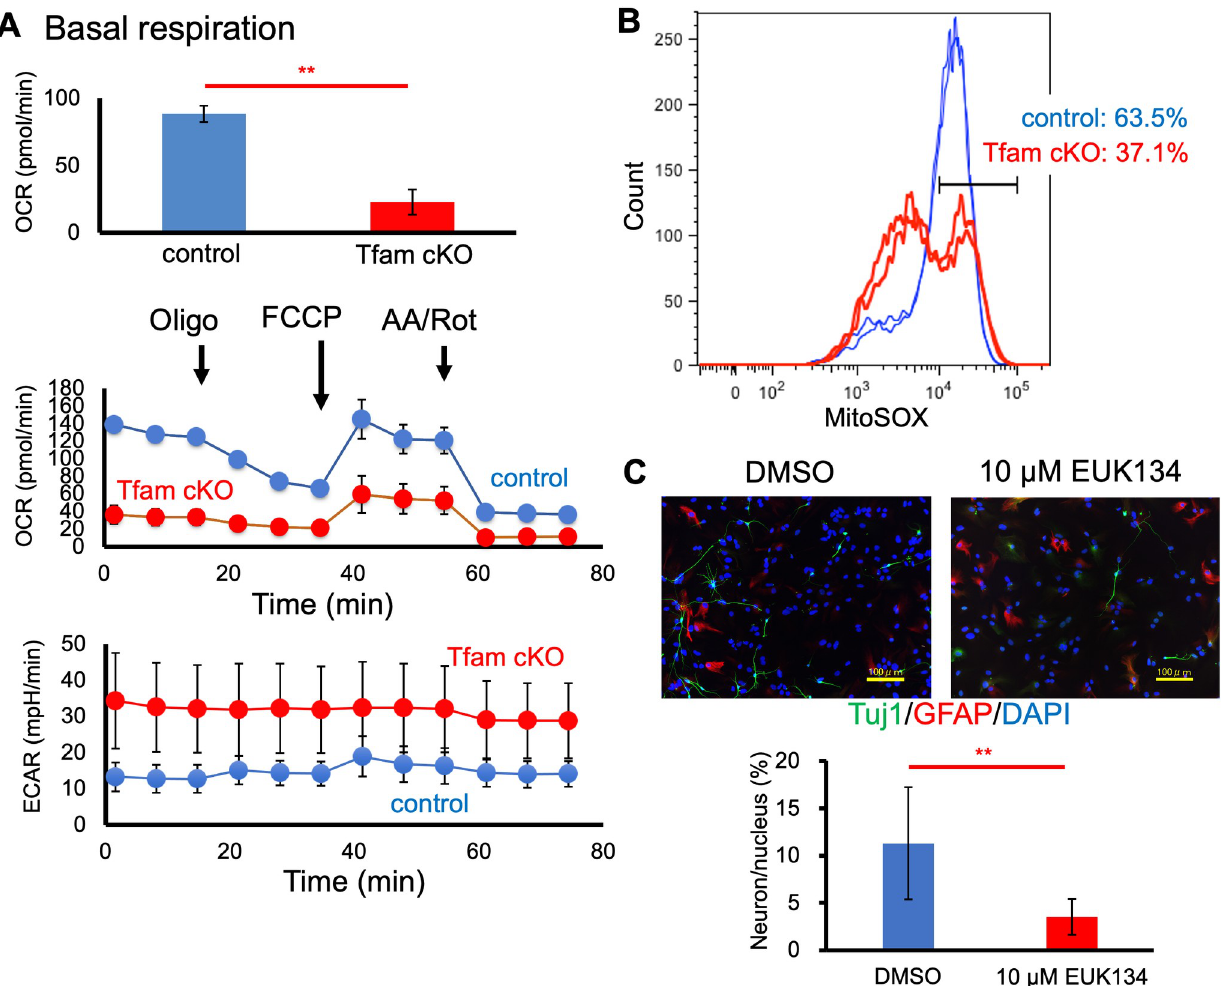
Fig 3. Altered cellular metabolism and ROS production in Tfam cKO cultured NSCs. (A) Oxygen consumption rate (OCR) and extracellular acidification rate (ECAR) of control and Tfam cKO NSCs were measured using a flux analyzer. Basal respiration, OCR, and ECAR are indicated. The graph shows means ± SD. n = 3 per group. �� P < 0.01. At least three independent clones per genotype were measured. (B) Mitochondrial ROS was measured by flow cytometry using the ROS-sensitive MitoSOX Red dye. The results from two controls (blue) and two Tfam cKO NSCs (red) are shown. Two independent experiments were performed. (C) Immunocytochemical analysis of differentiation of control NSCs cultured in the presence of either EUK134 or DMSO as a vehicle control. Neurons and astroglia were detected by immunostaining using anti-Tuj1 and anti-GFAP antibodies. DAPI was used for nuclear staining. The graph shows means ± SD. �� P < 0.01. Two independent experiments were performed. Scale bars, 100 μ m.